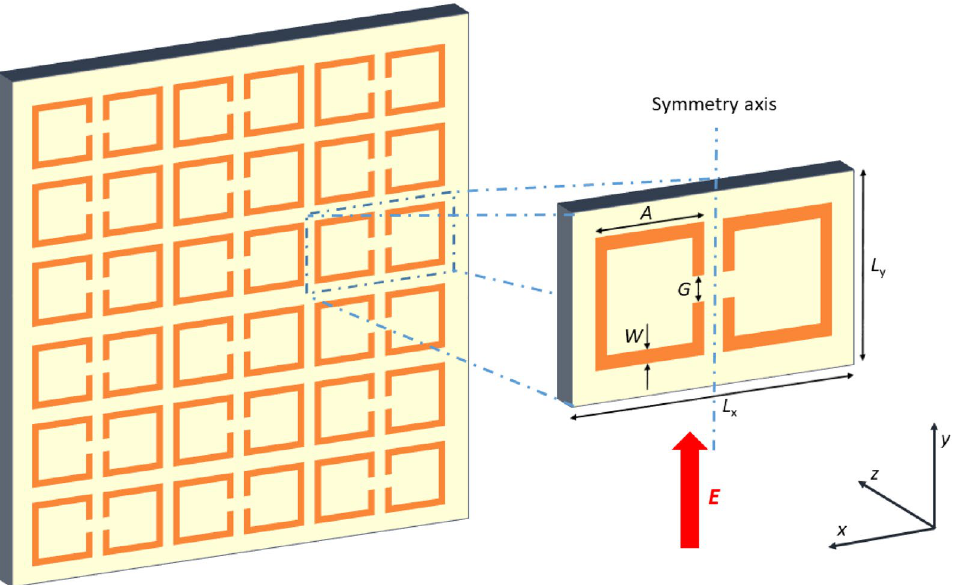
Figure 1. Schematics of the mirrored array of SRRs and enlarged single unit cell. Dimension of the unite cell in x direction L x is two times larger than L y = 600 μm. The dimensions of SRR are A = 500 μm, W = G = 50 μm, the metallization thickness is 10 μm, and the external electric field is parallel to the y